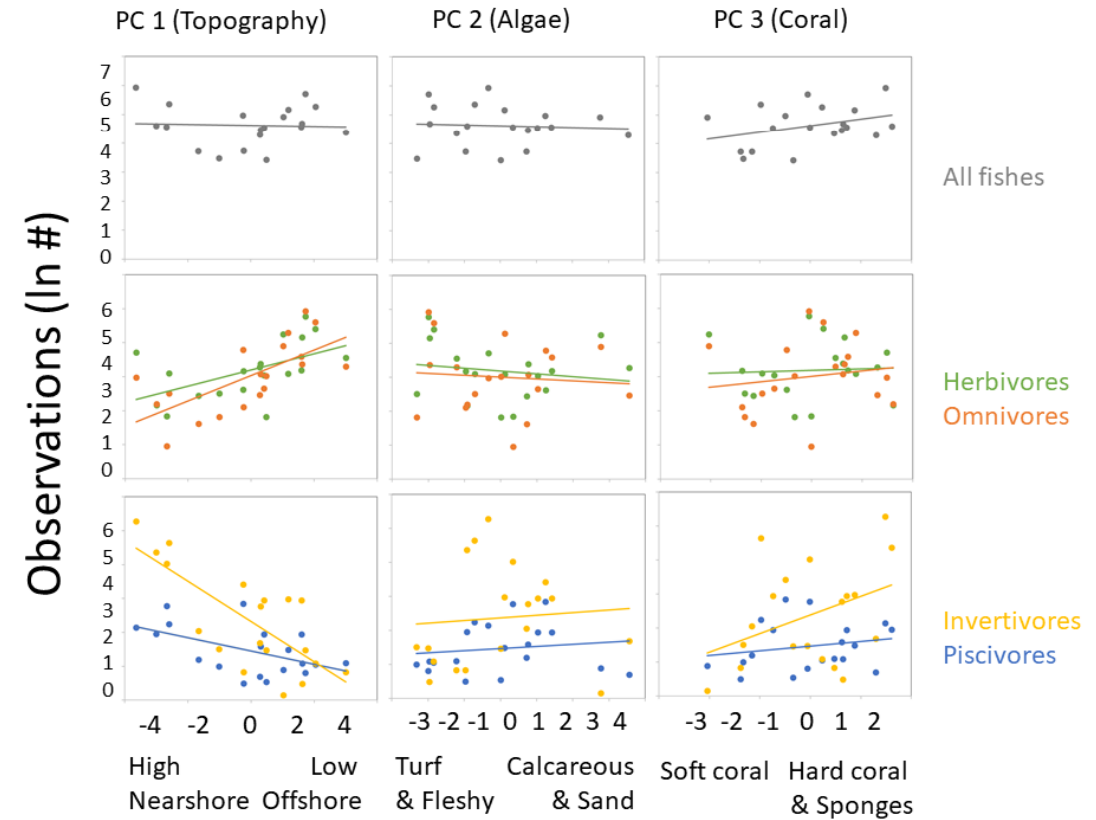
Figure 4. Linear regressions of mean numbers of fish observed (log-transformed) for the structure surveys within a reef site versus the three component scores that best describe the reef characteristics. The three component scores, from left to right, are topography (PC1), algae (PC2), and coral cover (PC3). The specific loadings of the reef measures for each component score are in Table 1. Graphs include all reef fish combined (gray), herbivores (green), omnivores (orange), invertivores (yellow), and predators (blue).